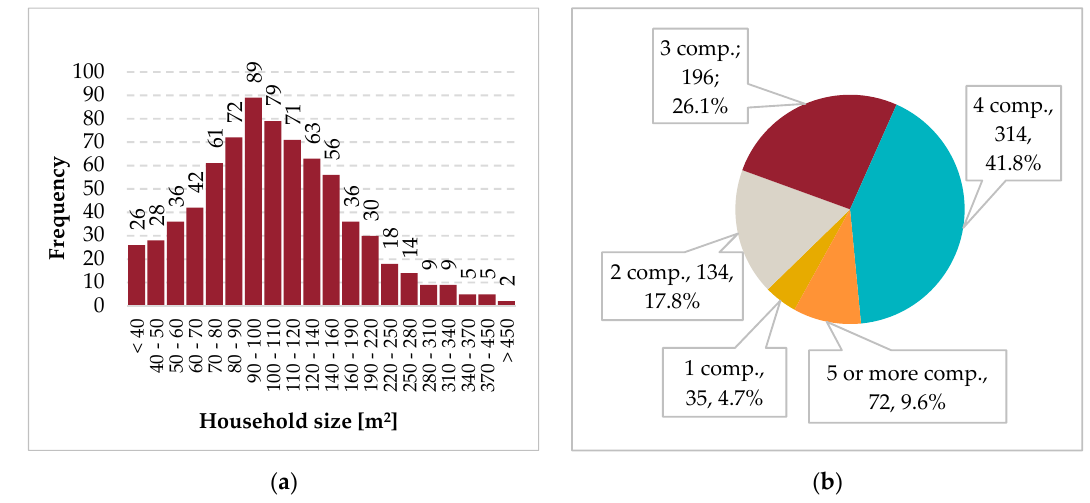
Figure 3. Building subdivision. ( a ) Household size. ( b ) Family occupancy.